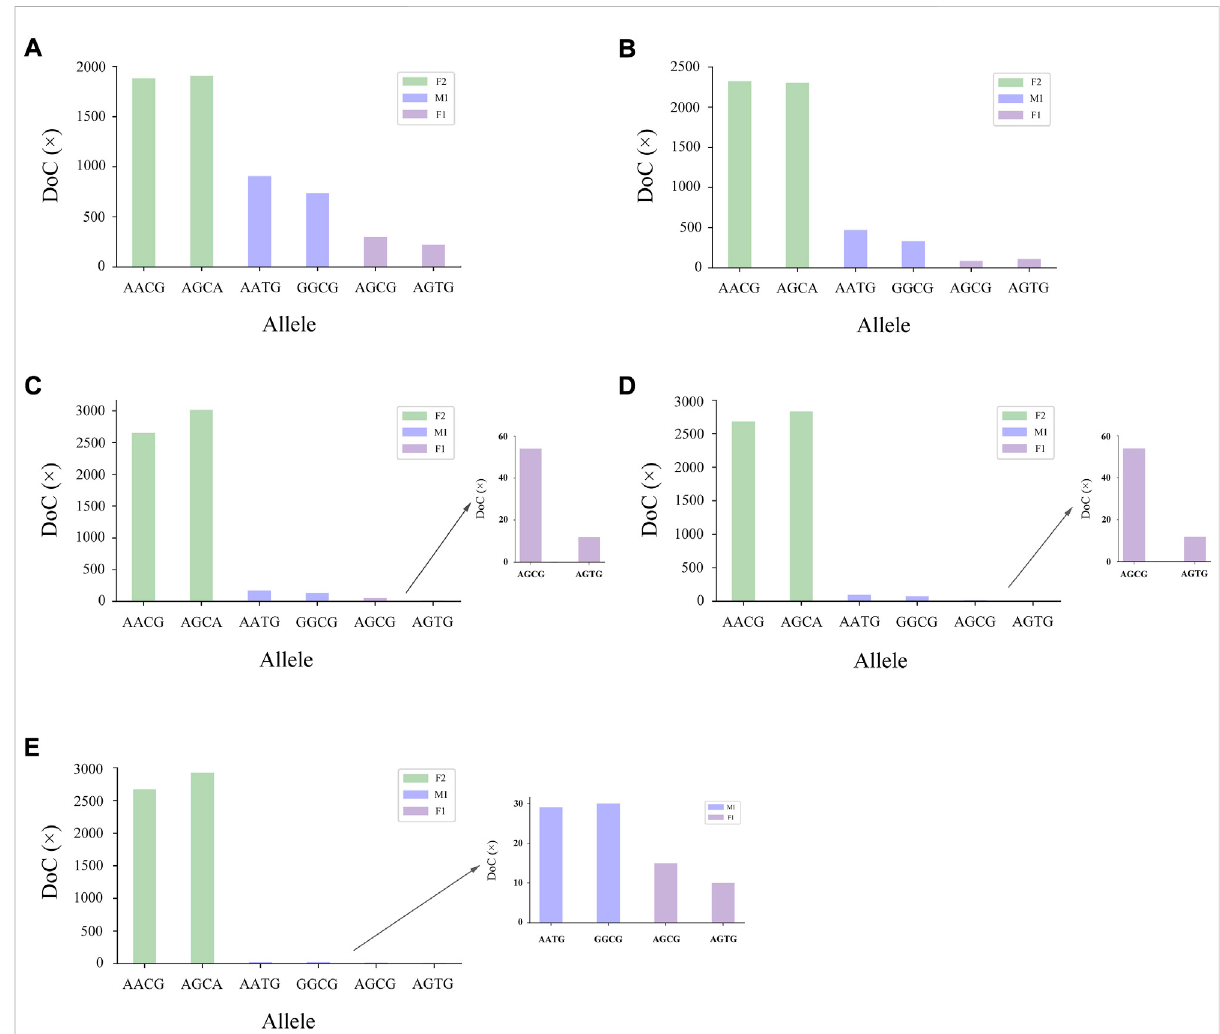
FIGURE 4 Schematic diagram of three-person mixture at MH13KK217 locus. The alleles of F2 were AACG/AGCA, the alleles of M1 were AATG/GGCG, and the alleles of F1 were AGCG/AGTG. (A) Mix ratio = 7:2:1, (B) Mix ratio = 17:2:1, (C) Mix ratio = 47:2:1, (D) Mix ratio = 97:2:1, and (E) Mix ratio =